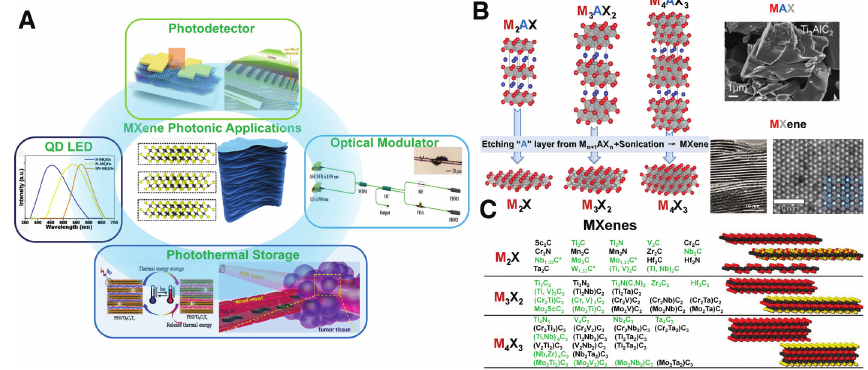
Figure 1: Schematic of MXene optoelectronic applications, synthesis process and family members. Schematic of MXene application for optoelectronic devices (A), synthesis of MXene from MAX phase and TEM images of Ti3AlC2 MAX (right, top) and Ti3C2Tx MXene (right, bottom) (B), and reported MXenes based on theoretical predictions (marked in black) and